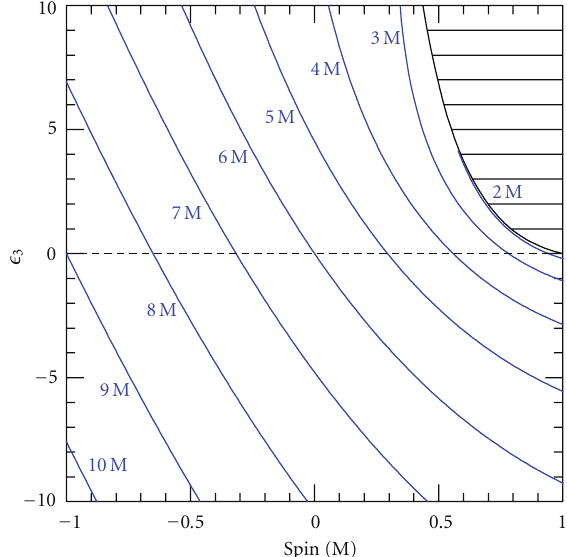
Figure 3: Contours of constant radius of the ISCO for values of the spin − 1 ≤ a/ M ≤ 1 and of the parameter − 10 ≤ (cid:2) 3 ≤ 10. The radius of the ISCO decreases for increasing values of the spin and the parameter (cid:2) 3 . The shaded region marks the excluded part of the parameter space. The dashed line corresponds to the parameter space for a Kerr black hole